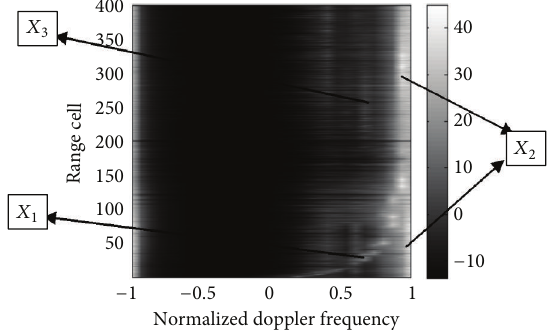
Figure 3: Clutter spectrum distribution of forward-looking planar array in range-Doppler